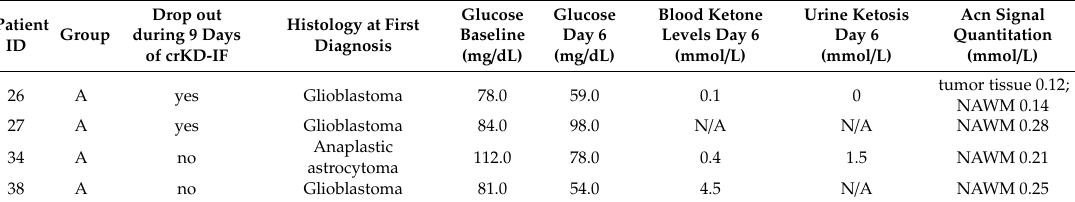
Table 2. Quantitation of intracerebral KB in patients with KB signals with an estimated CRLB < 35% as given by